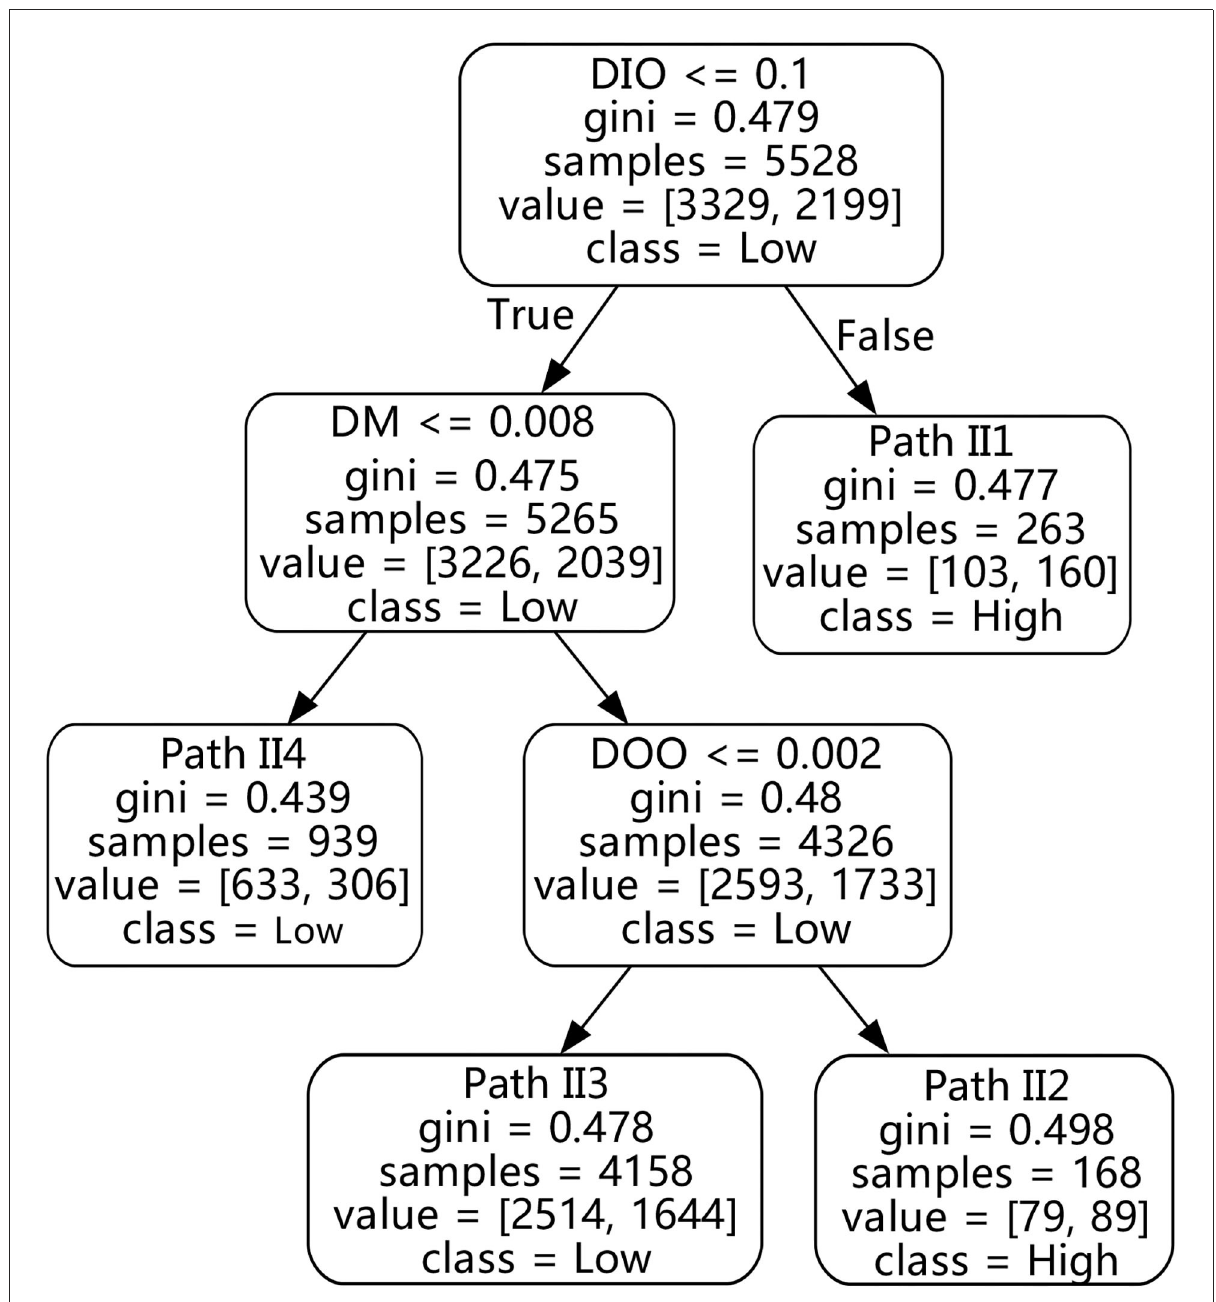
FIGURE8 Decision tree for general digitalization